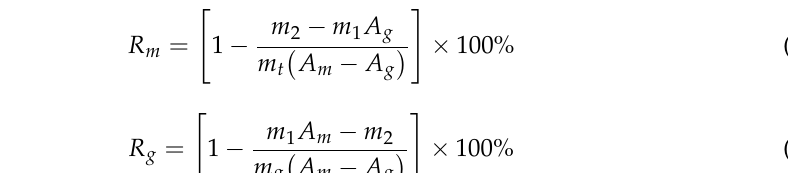
Figure 5. The schematical illustration of the RK/FGC5-35 flotation cell. In mixed flotation, the flotation recoveries of graphite and gangue minerals were calculated by Equations (4) and (5) [32].